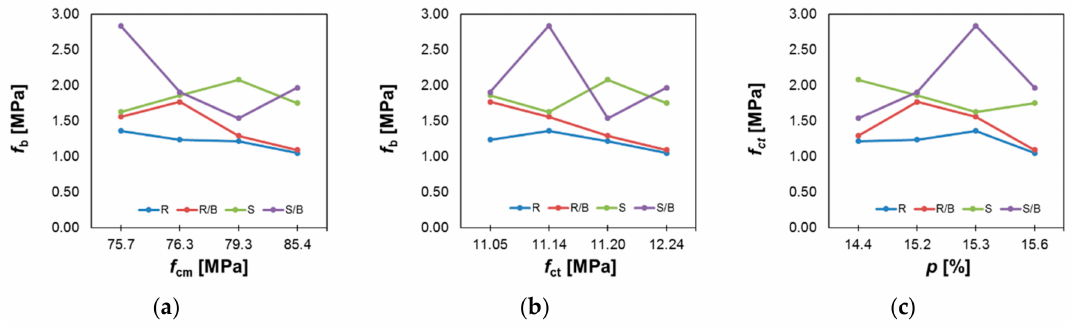
Figure 7. Relationship between the pull-o ff adhesion f b values and the values of: ( a ) compressive strength f cm , ( b ) flexural strength f ct and ( c ) porosity